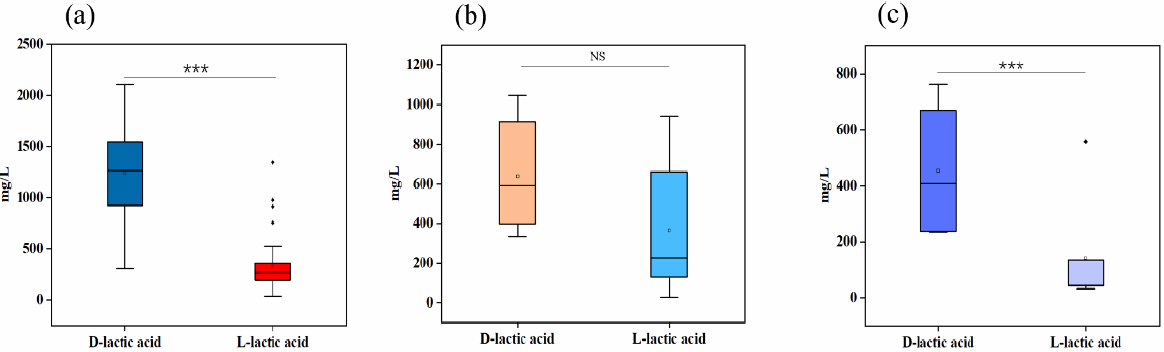
Figure 3. Box plots of D-lactic acid and L-lactic acid contents in SSB ( a ), STB ( b ), and LTB ( c ). t -test: NS (not significant, p > 0.05); ***: p < 0.001. So far, the formation pathway of lactic acid enantiomers in Baijiu has not been clarified. Many microorganisms have been reported to have the ability to produce L-lactic acid, such as Lactobacillus , Bacillus coagulans , and various transgenic strains [32]. Lactic acid is an important metabolite produced by lactic acid bacteria during fermentation, and high levels of lactic acid may lead to rancidity [33]. Lactic acid is a ubiquitous metabolite that occurs frequently during fermentation of fermented foods and beverages [34,35], and is one of